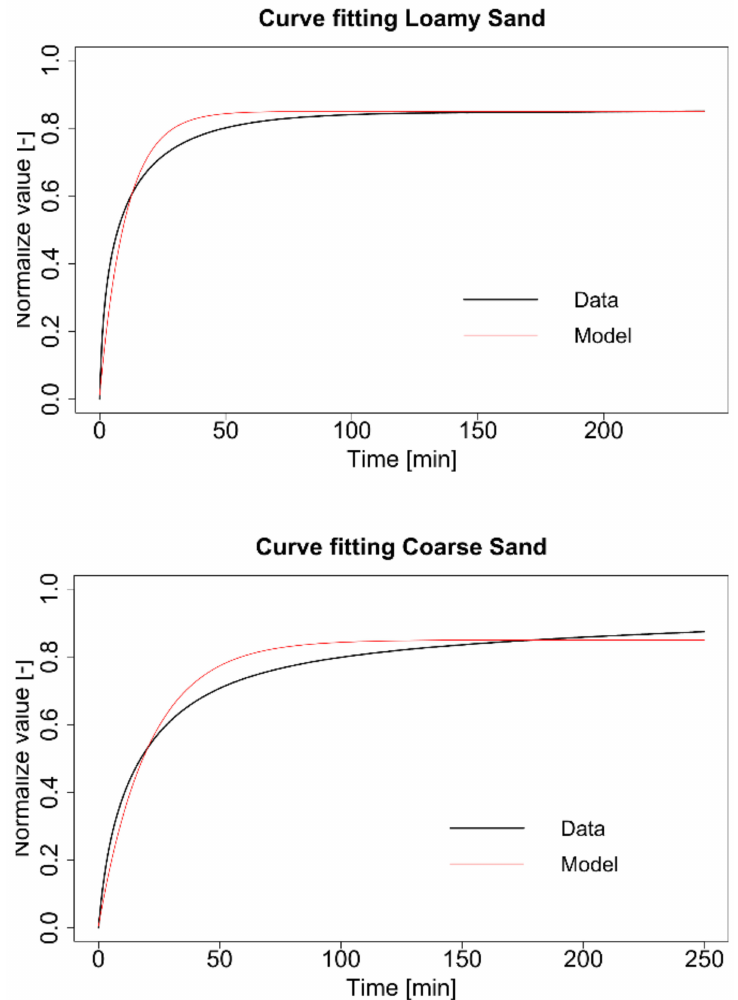
Figure 3. Fitting mean empirical course (black line) with the modified equation of cumulative distribution function (red line) for loamy sand ( up ) and coarse sand ( down